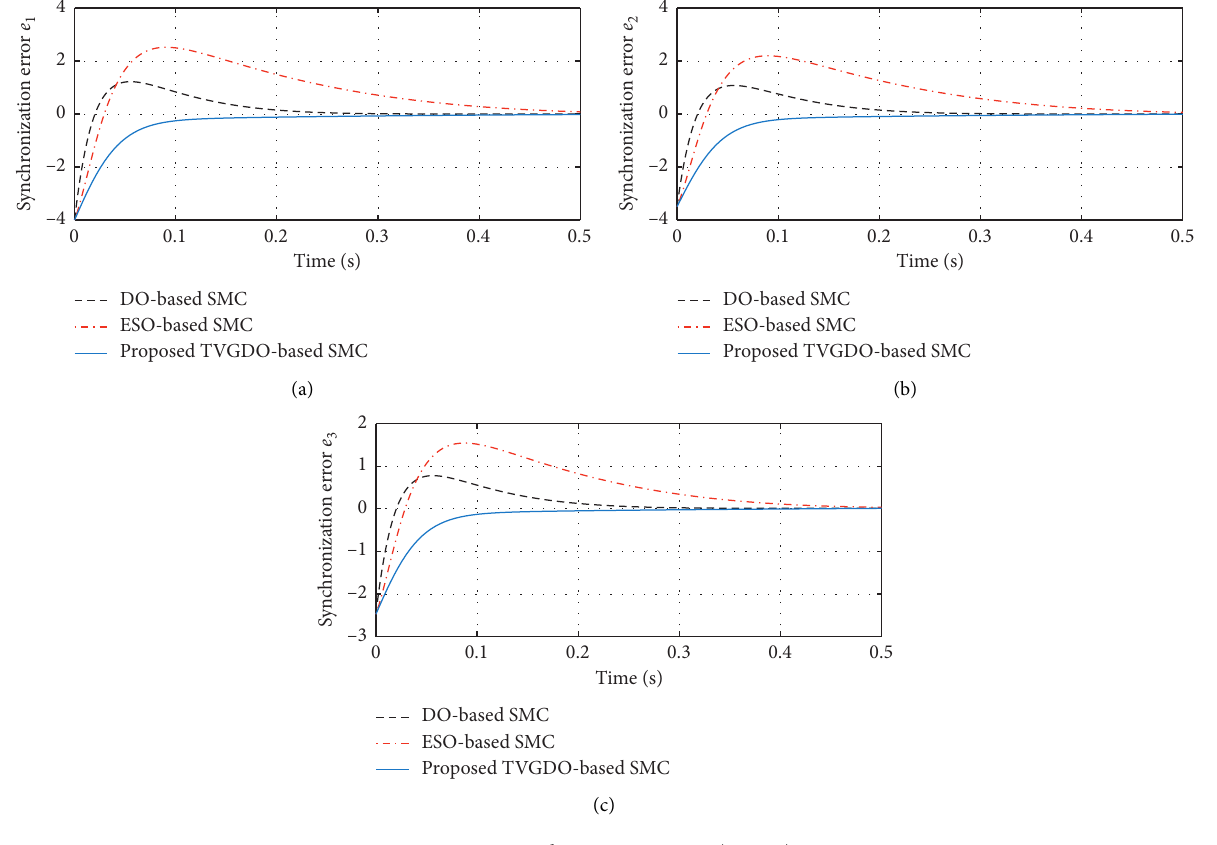
Figure 6: Synchronization error (Case 2).